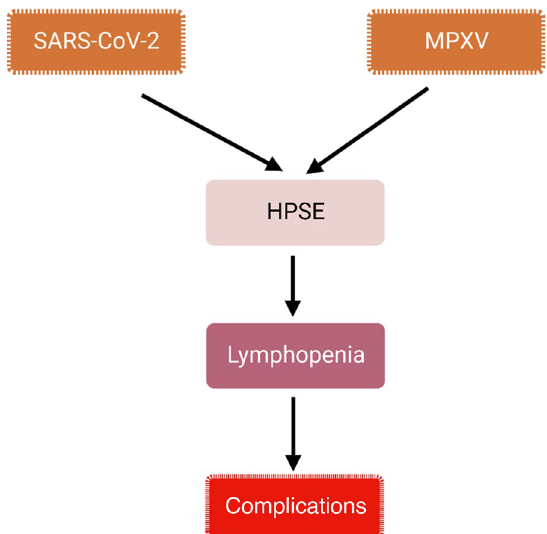
Fig. 6 The possible link between SARS‑CoV‑2 and MPXV infections: SARS‑CoV‑2 and MPXV infections activate heparanase (HPSE) leading to lymphpenia which cause